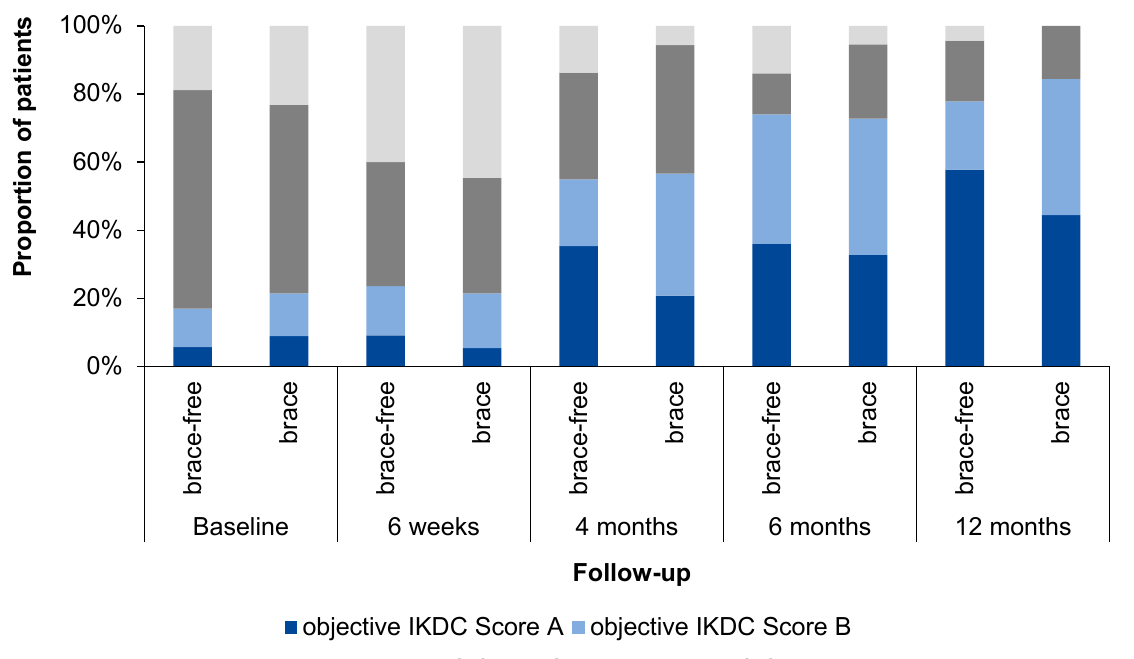
Figure 4. The objective International Knee Documentation Committee grading.